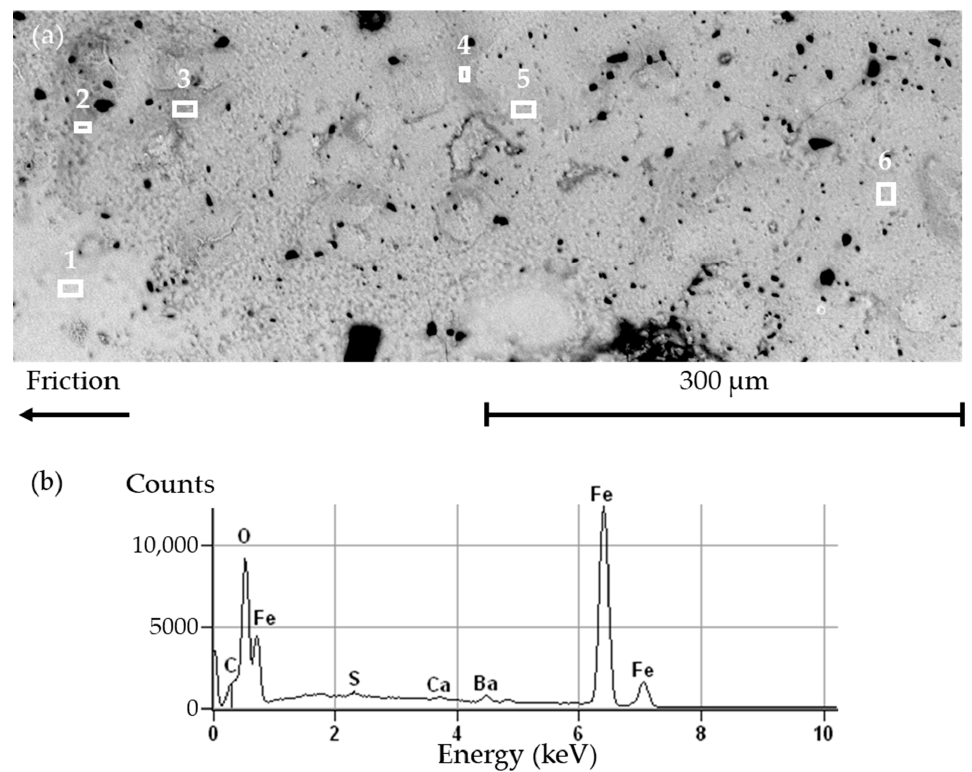
Figure 11. Worn surface of an LS pad: ( a ) SEM backscattered electron image; ( b ) EDS spectrum representative of analyses 1 to 6 (accelerating voltage 20 kV, working distance 14.1 mm). Materials 2021 , 14 , x FOR PEER REVIEW